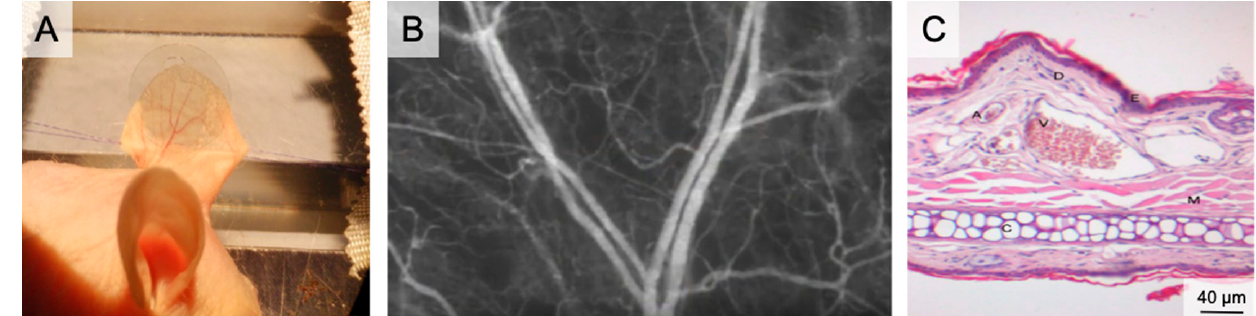
Figure 2. The auricle of the hairless SKH1 -hr hr mouse. ( A ) Positioning of the mouse auricle for intravital microscopy. The image shows the auricle fixed using two 6/0 sutures and after placement of a glass cover slip, which enables water immersion during fluorescence microscopy. ( B ) Intravital microscopy of the main branching of the neurovascular bundle in 50× magnification following iv FITC-dextran injection. ( C ) HE histology of the auricle illustrating the rich vasculature (A–arteriole; V–venule; D–dermis; E–epidermis; M–muscle;